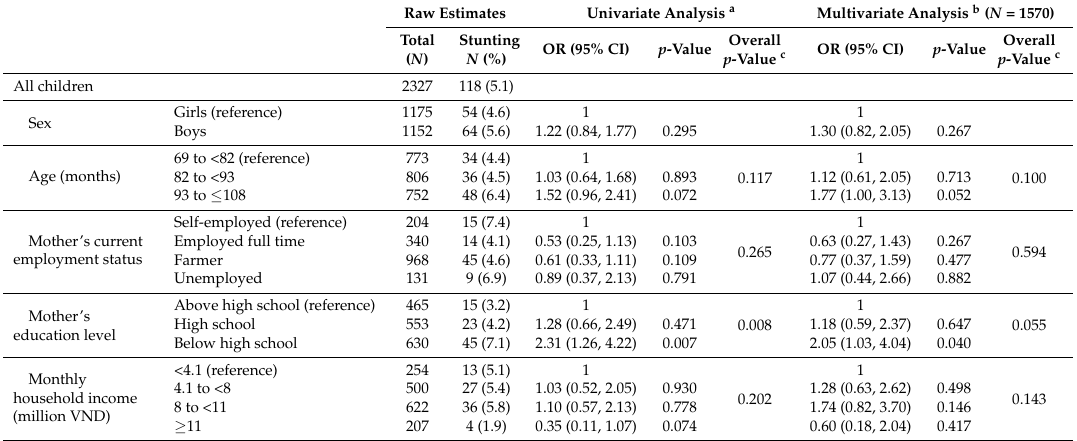
Table 3. Prevalence of stunting (height-for-age z -score < − 2) and associated sociodemographic factors in 6–9-year-old children in rural areas of Vietnam.